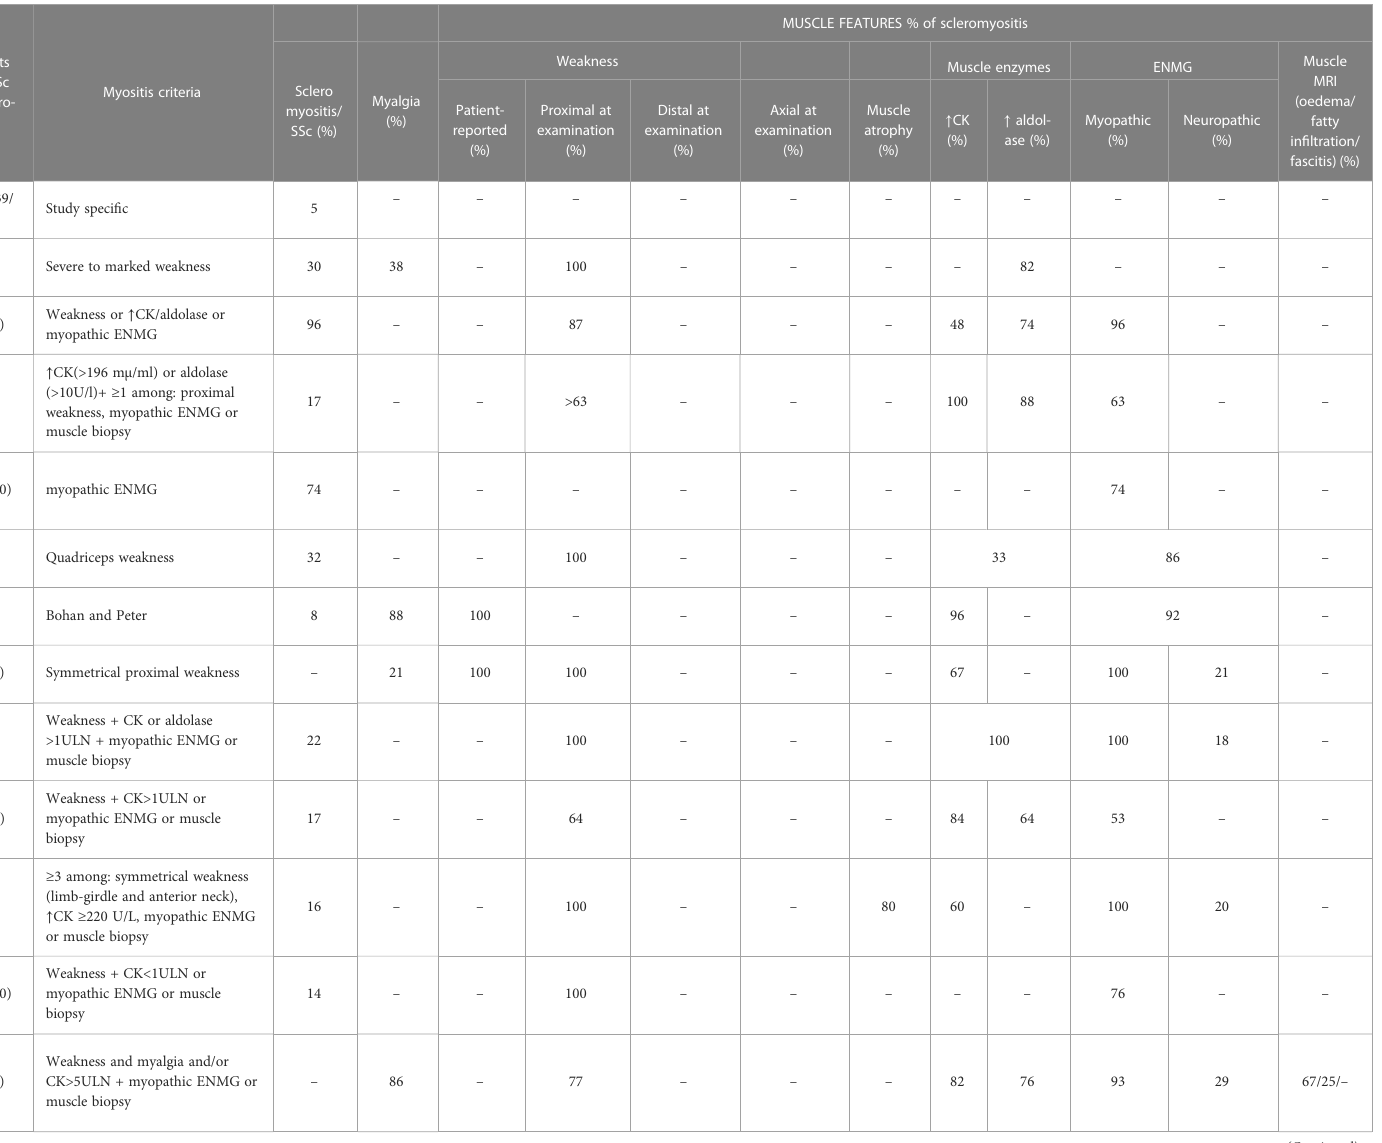
TABLE 2 Prevalence and characteristics of scleromyositis in systemic sclerosis